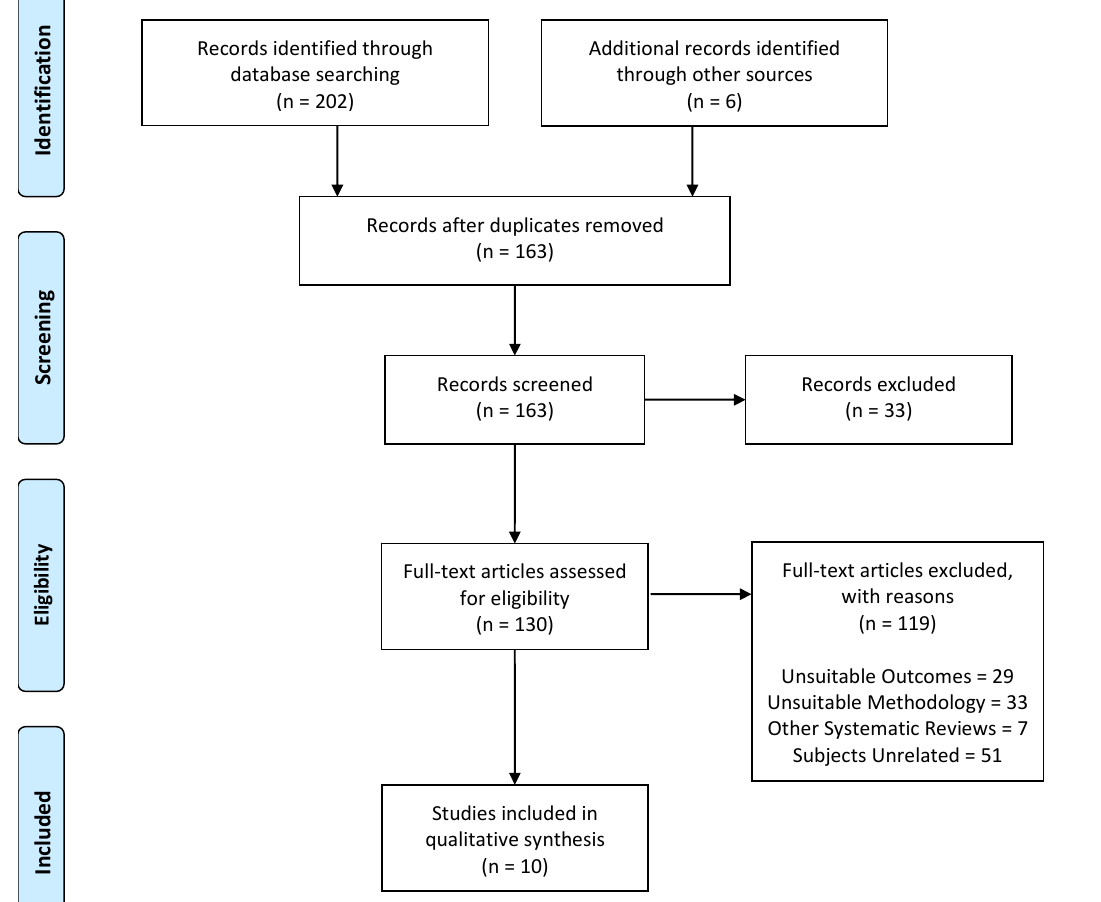
Figure 1. Selection of studies (Preferred Reporting Items for Systematic Review and Meta-Analyses (PRISMA), 2009 Flow Diagram).